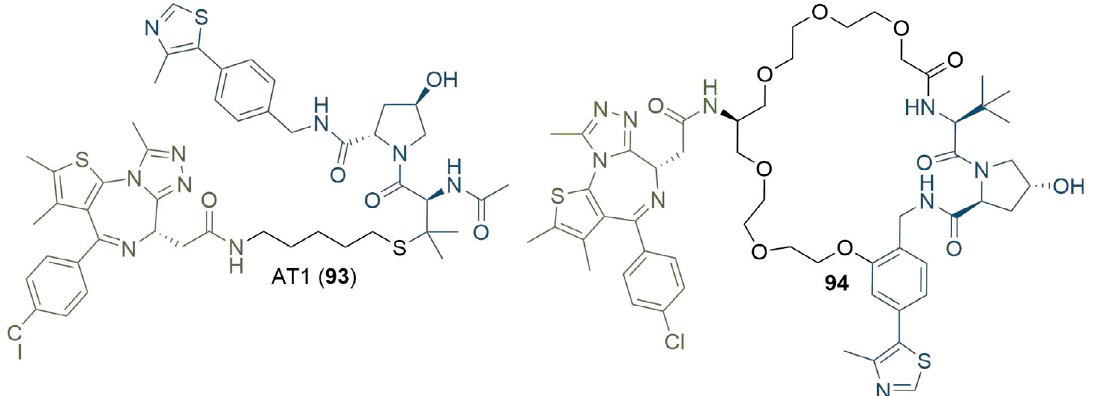
Figure 19. Rational design of PROTACs from TC crystal structures. The crystal structure of MZ1 (1) suggested that the tert -butyl moiety was a better site for linker conjugation, which was used to product AT1 (93). Macrocyclisation of 1 to retain its binding conformation in the TC crystal structure afforded